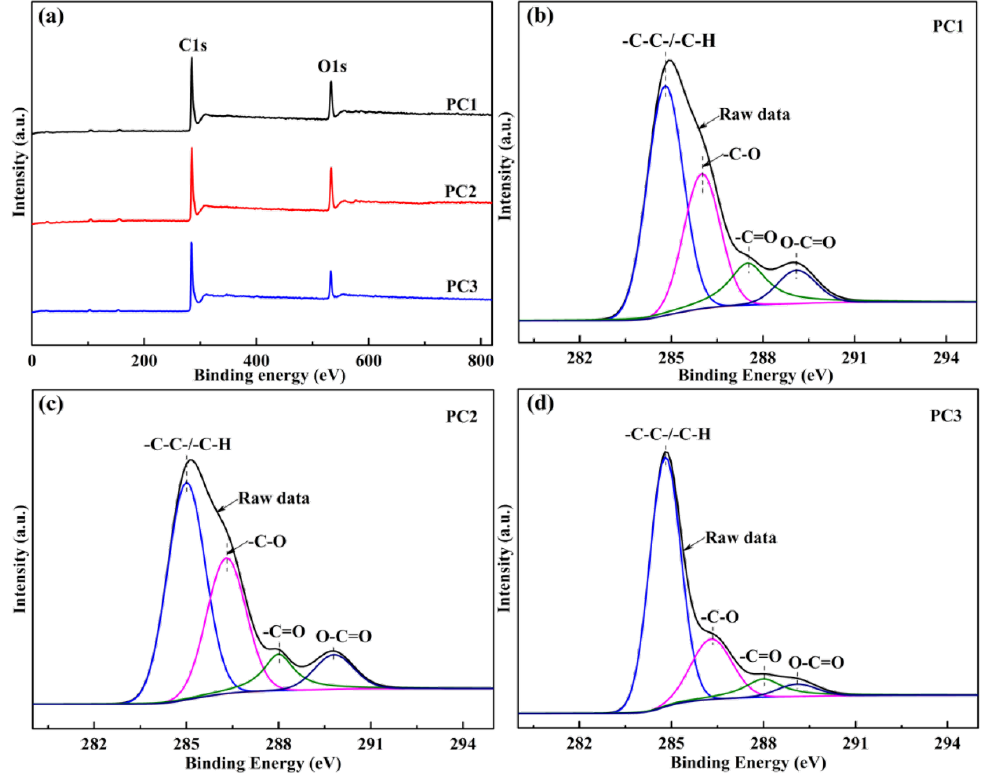
Figure 5. The X-ray photoelectron spectra (XPS) ( a–d ) of PCs: ( a ) the XPS wide-scan spectra, the high resolution for ( b–d ) C1s spectra of samples. PCs: porous carbons. resolution for ( b–d ) C1s spectra of samples. PCs: porous